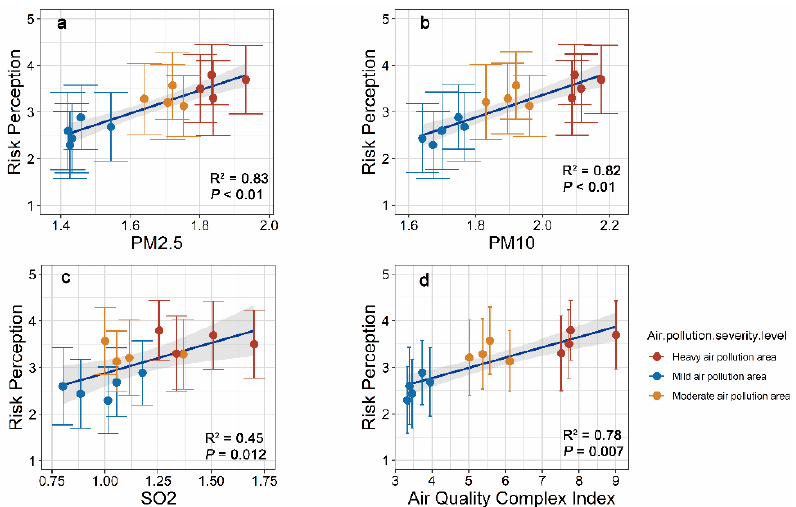
Figure 1. The relationship between PM 2 . 5 , PM 10 , SO 2 average concentration, air quality composite